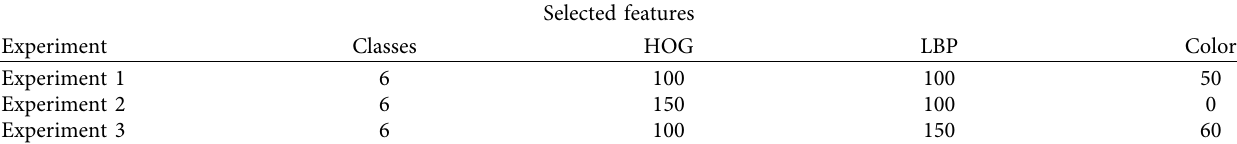
Table 1: Selected features in experiments.